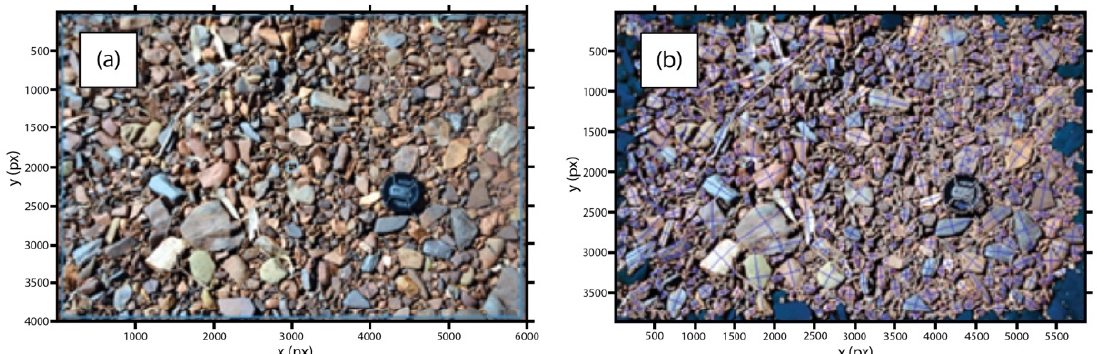
Figure 6. BASEGRAIN software images ( a ) shows the raw image input and ( b ) shows the detection of intermediate and long axis. Sediment clasts that intersect the analysis frame are darkened here and removed from the measurement.